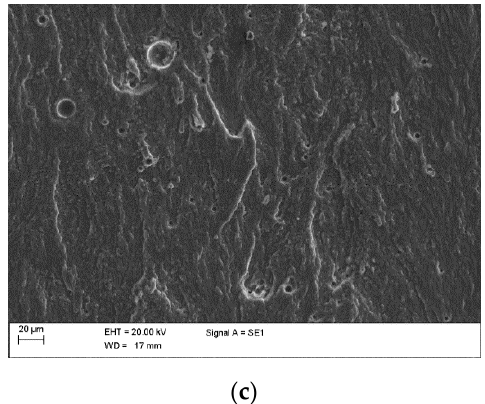
Figure 5. Types of critical defects: ( a ) Defect due to incomplete fusion; ( b ) defect due to improper bonding; ( c ) non critical pores found within the specimen volume.